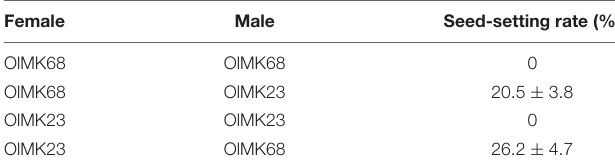
TABLE 1 | Seed-setting rate after self-/cross-pollination in O. longistaminata . Female